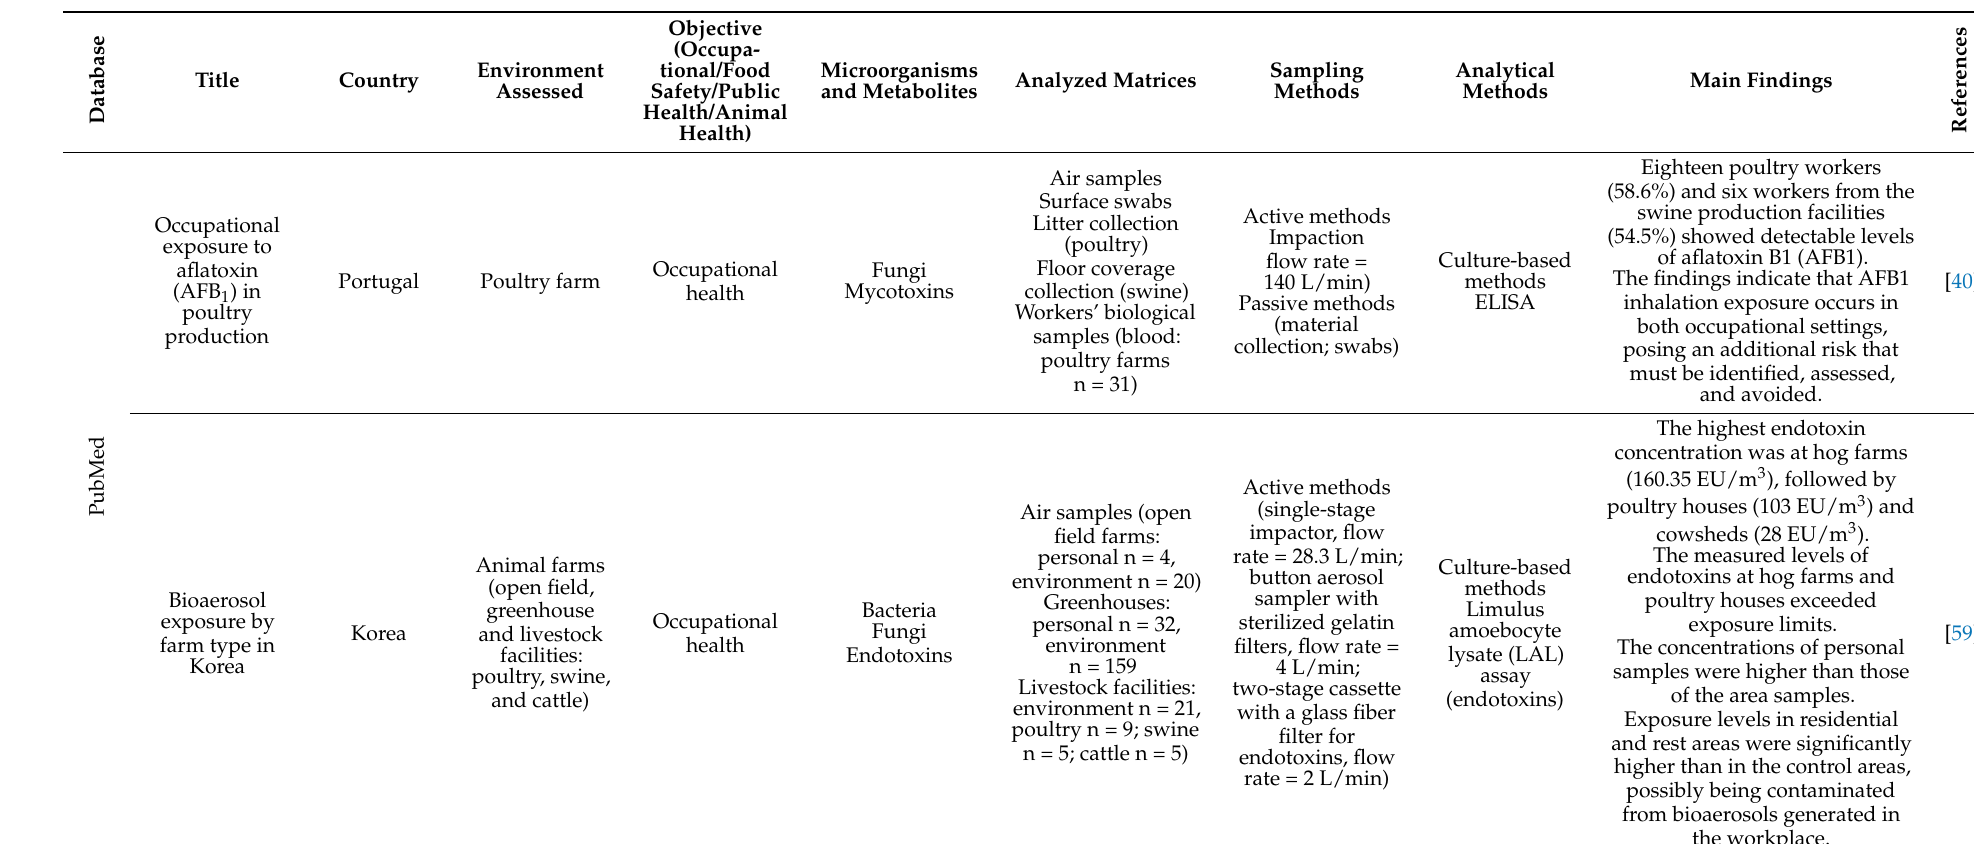
Table 2. Characteristics of and Data Obtained in the Selected